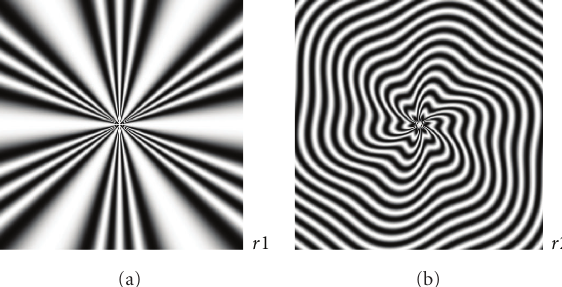
Figure 14: Interferogram when the test wave φ t 1 of Figure 13(c) interferes with (a) reference wave φ r 1 = mθ and (b) reference wave φ r 2 = mθ + Cr .